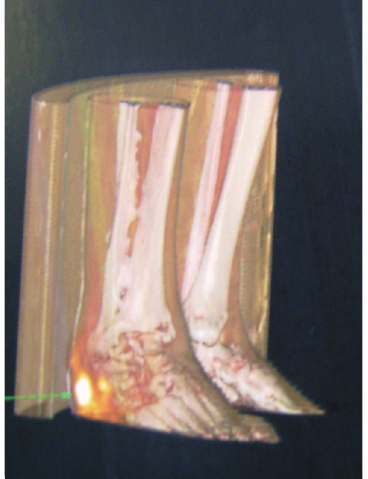
Figure 3: CT scan 3D of lower